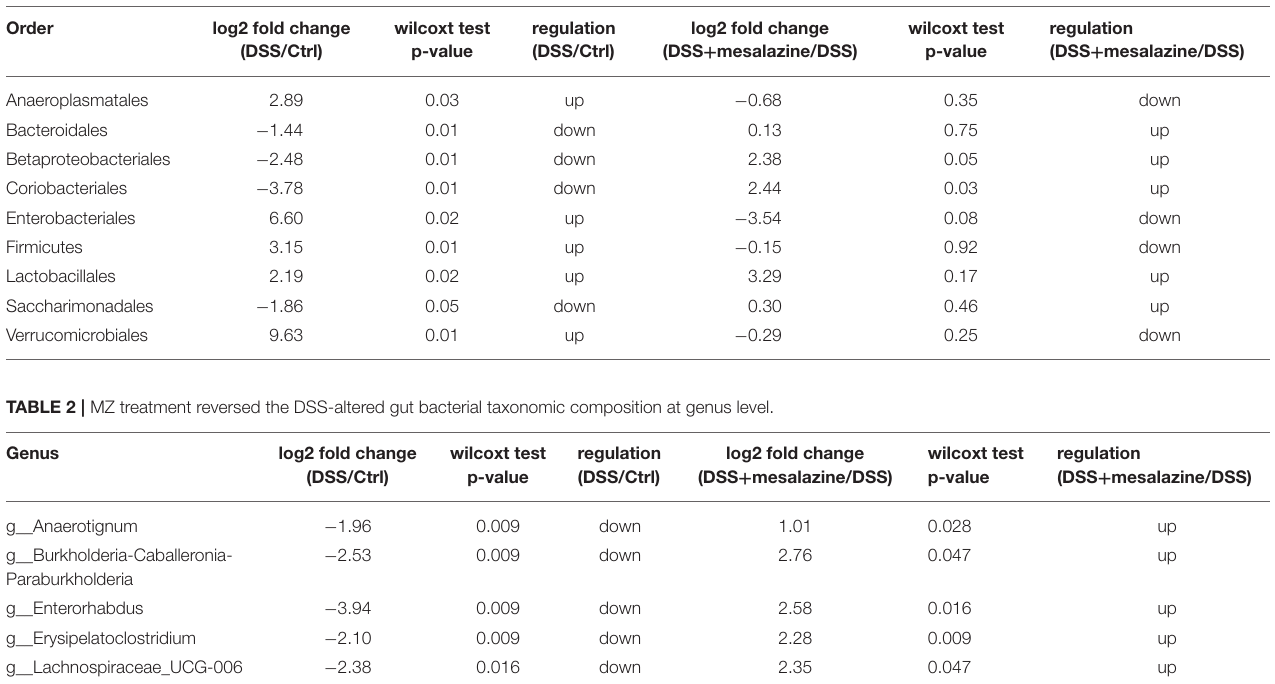
TABLE 1 | MZ treatment reversed the DSS-altered gut bacterial taxonomic composition at order level. Order